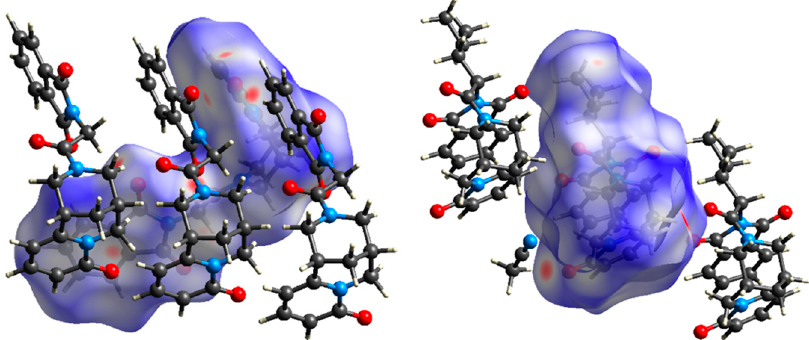
Figure 6 . Hirshfeld surfaces of molecules 3A (left) and 3E (right) with the closest neighbors. In N -[glycine-( N -phtaloyl)]cytisine ( 1 ), the most pronounced contact is related